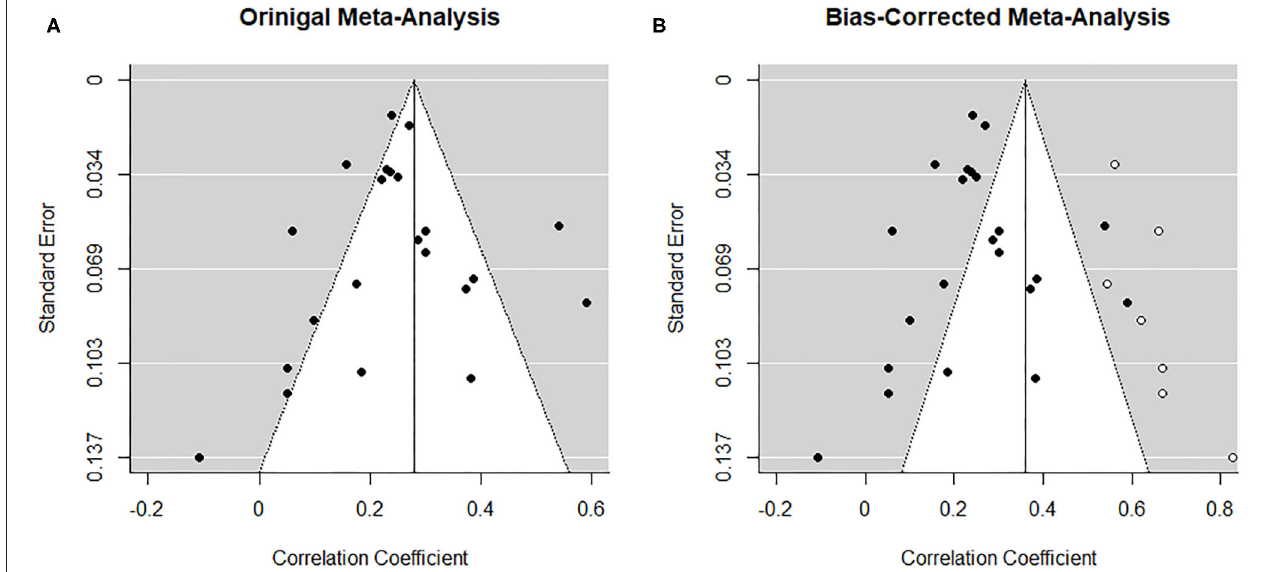
FIGURE 5 | Funnel plots before (A) and after (B) applying trim-and-fill method corresponding to the association between paternal and maternal depression during the postnatal period. The open dots indicate imputed studies.